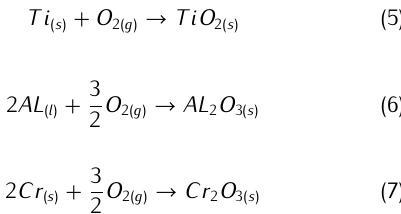
∆ G o T )ofTiNandTiO 2